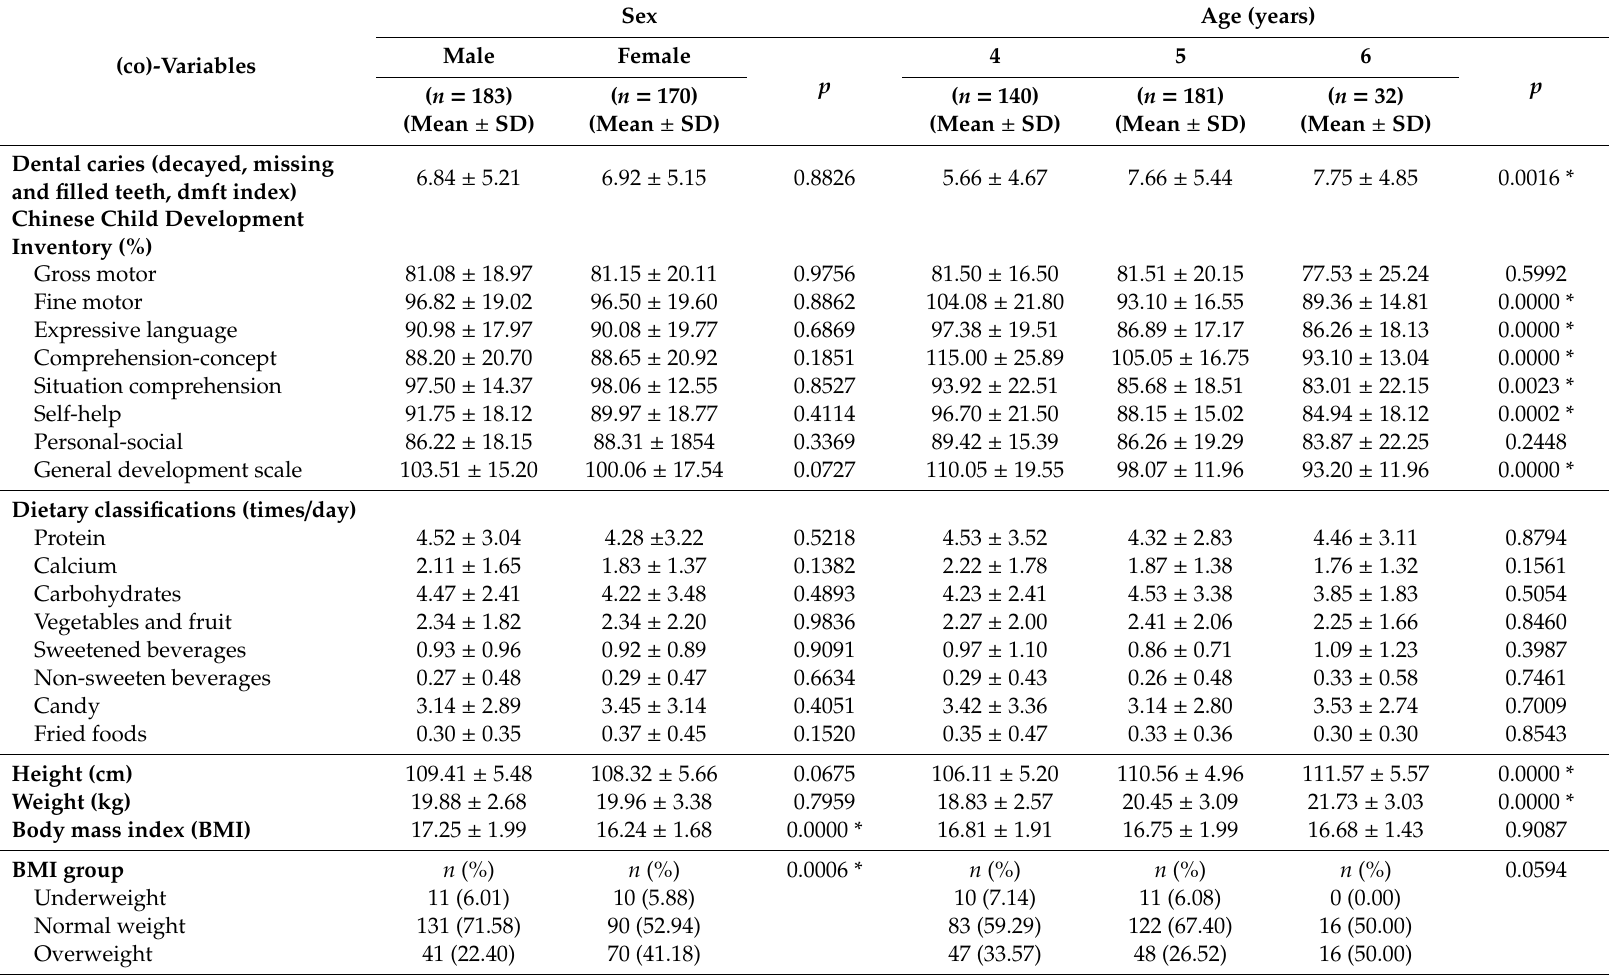
Table 1. Dental caries, CCDI, dietary status, height, weight and BMI of di ff erent gender and age